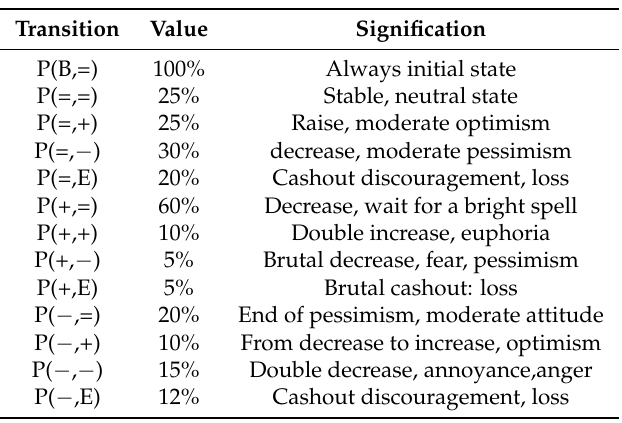
Table 3. Transition